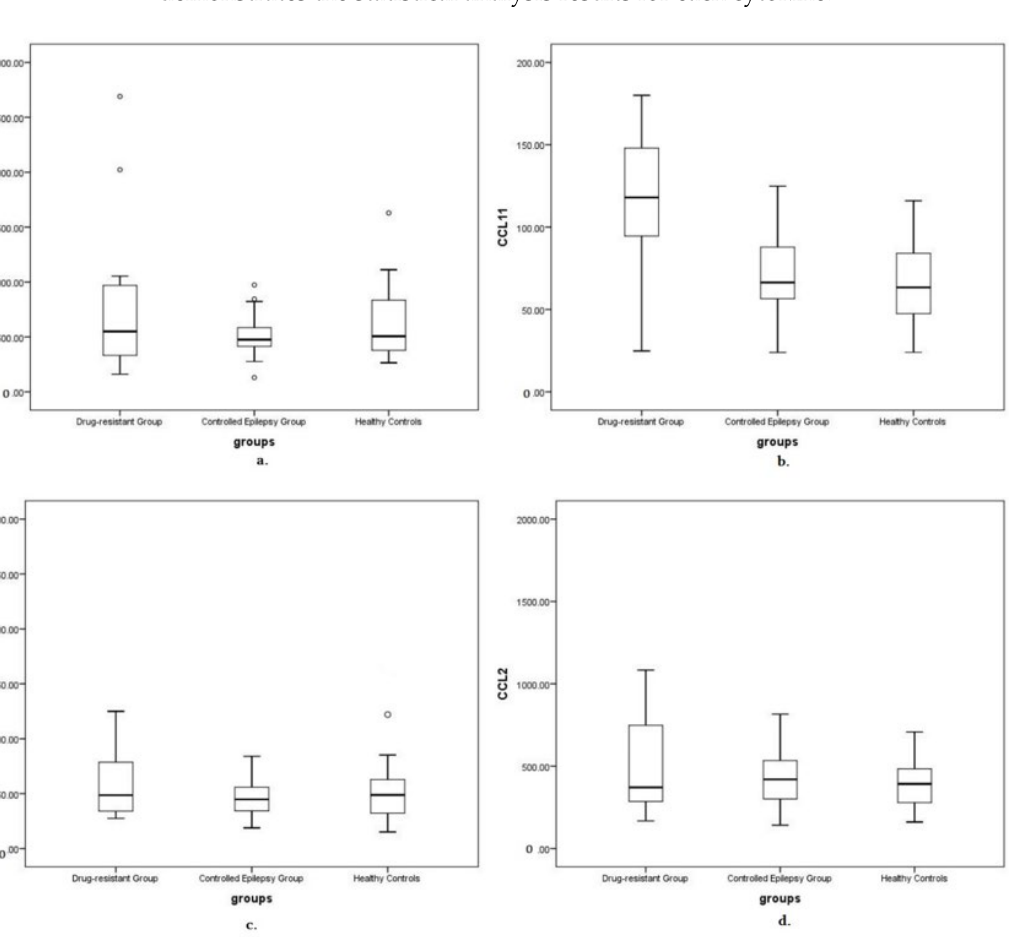
Figure 1. A comparison of serum interictal cytokine levels in drug-resistant, controlled epilepsy and healthy control groups. Kruskal–Wallis test results showing the median, interquartile range (box) and 95% confidence interval of cytokines concentration in patients compared to controls. Measured in Table 3. The interquartile range (IQR) of targeted proinflammatory cytokine concentrations.